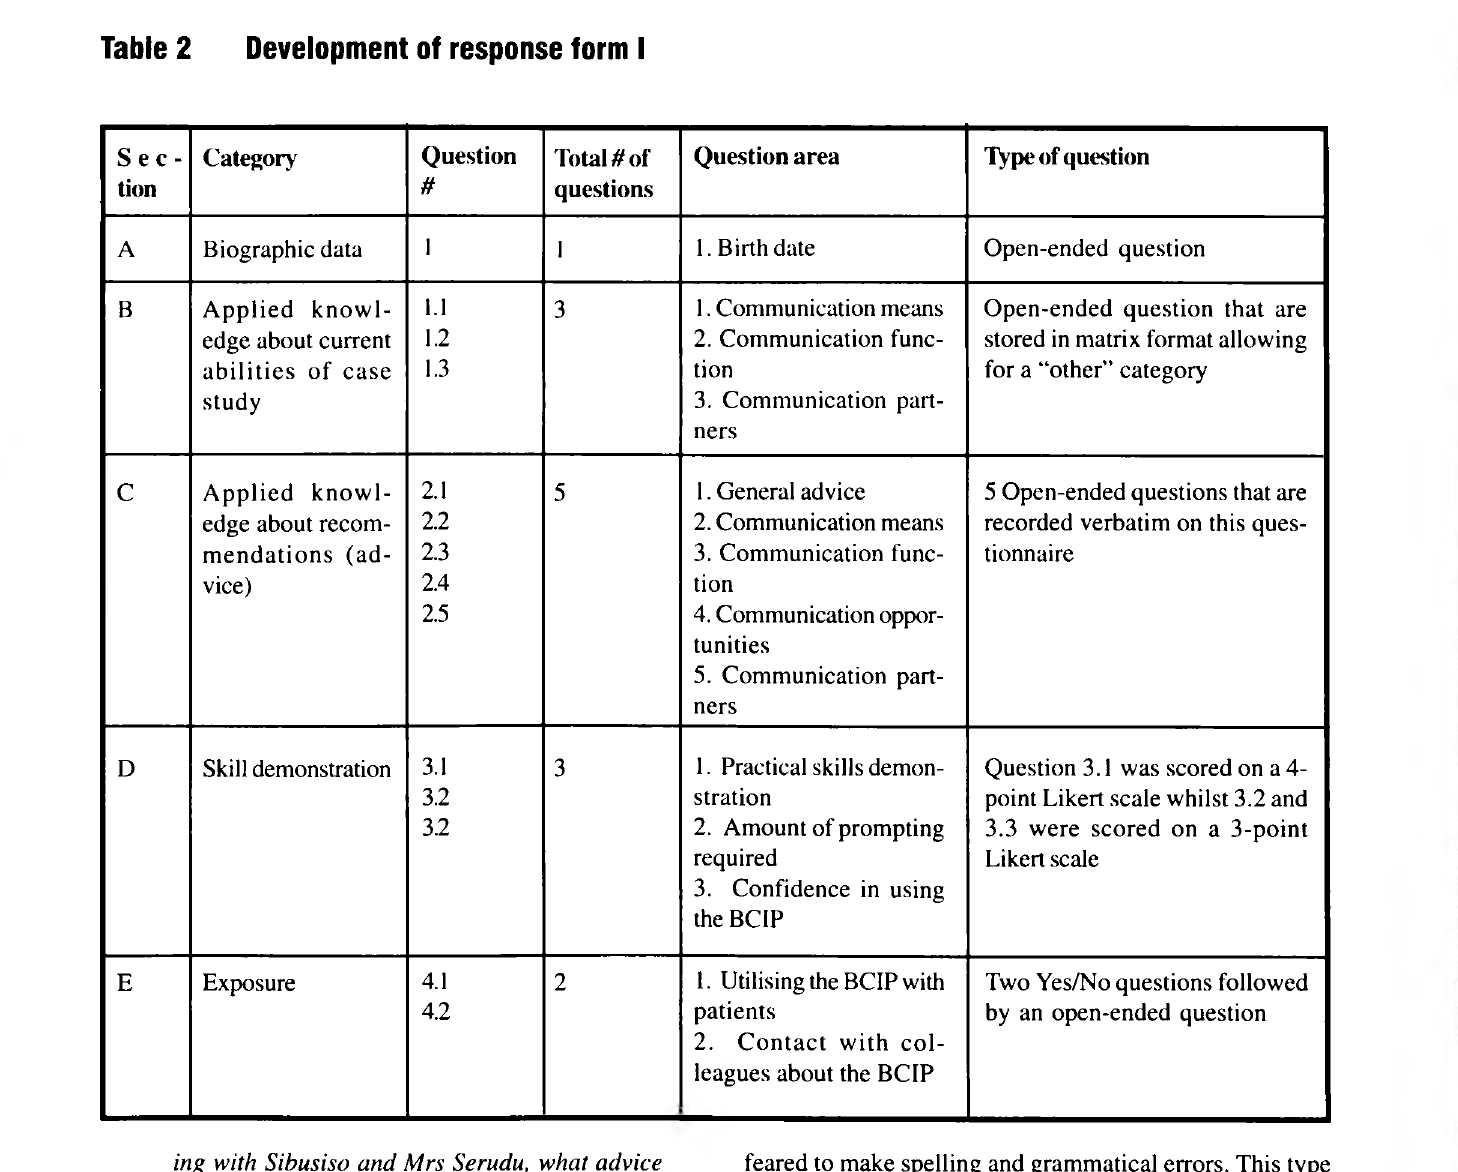
Table 2 Development of response form